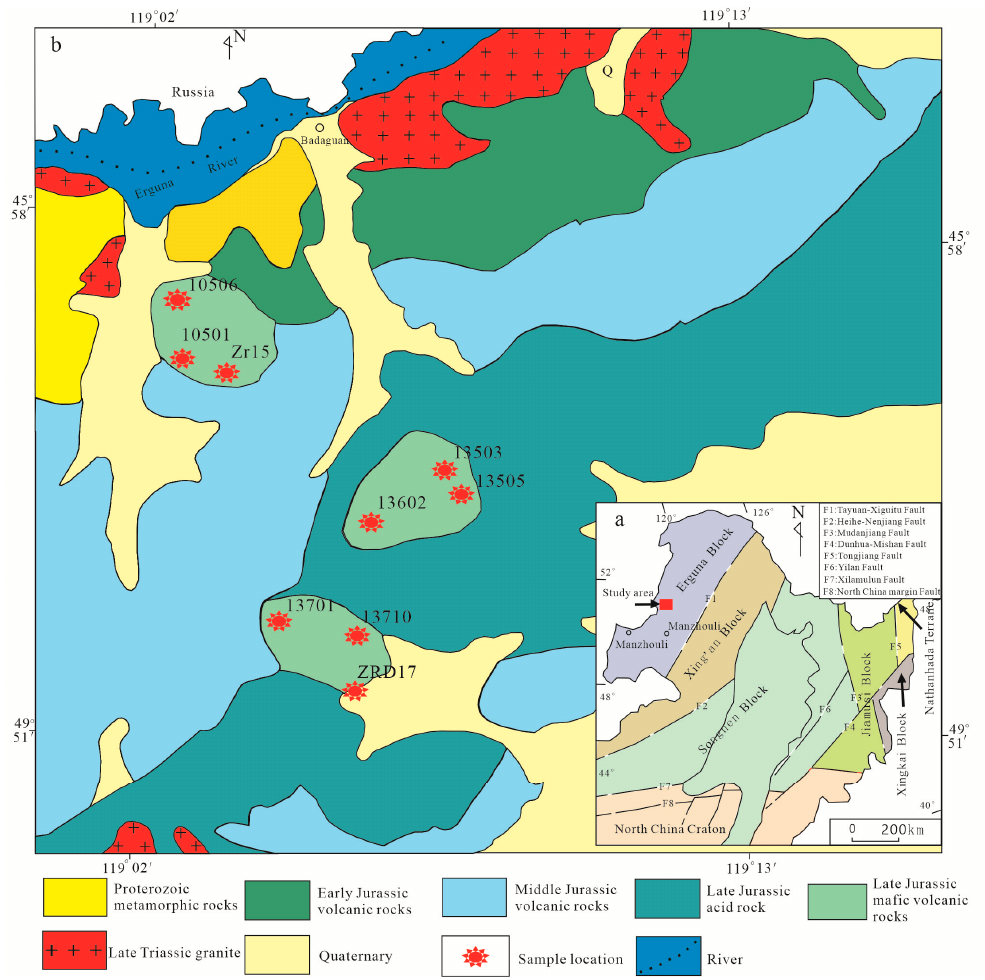
Figure 1. ( a ) Geological sketch map of Northeast China and ( b ) simplified geological map of Northwest Erguna block (modified after Li et al. [27]). At present, there is still controversy about the opening of the Mongol-Okhotsk Ocean, but the Late Paleozoic–Mesozoic evolutionary history is relatively clear. During this period, the Mongol-Okhotsk Ocean likely subducted both northward and southward [4,34,35]. The Mongol-Okhotsk Ocean evolution can be roughly divided into seven stages: (1) during the Devonian period, the Mongol-Okhotsk oceanic crust began to subduct at a low angle beneath the Siberian plate, causing diffuse lithospheric extension and contributing to the collapse of the Early Paleozoic orogenic belt; (2) during the Early–Late Carboniferous, the subduction steepened, prompting a shift from an extensional to an extrusion regime; (3) the Late Carboniferous–Early Permian subduction plate broke off and reversed, leading to the extension of the continental lithosphere and the upwelling of mantle material; (4) Late Permian–Middle Triassic igneous rocks provide evidence for both northward and southward subduction polarity, a typical and active continental margin environment; (5) in the Late Triassic, the western part of the Mongol-Okhotsk suture zone closed, but the central and eastern oceans of the Mongol-Okhotsk Ocean were still open; (6) during the Early–Middle Jurassic period, magmatic activity in Transbaikal and North-central Mongolia weakened significantly, likely due to the subduction slowing down at its final stage, and the eventual closure of the oceans to form orogenic belts; (7) in the Late Jurassic– Early Cretaceous period, the eastern part of the Mongol-Okhotsk Ocean eventually closed, causing the granites of this period to have intraplate granite features